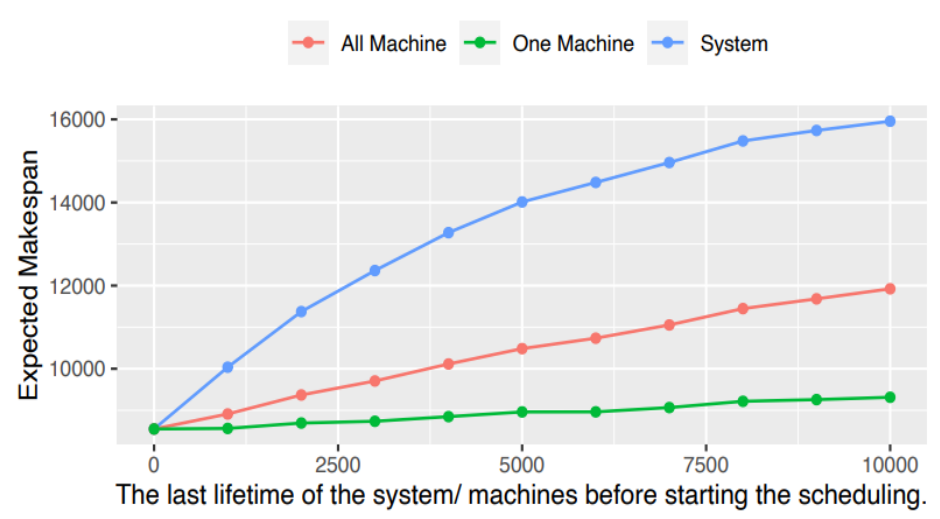
Figure 2. The Expected makespan of the system with the interval [0,10k] that indicates the last lifetime of the system/machines spent before executing the Car2 problem. In this figure 𝑷 𝒊𝒋∗ (𝒕)~ 𝑬𝑿𝑷(𝑷 line represents the Expected makespan computed according to the robust procedure in Proposition 1 and the orange one is devoted to illustrating the robust procedure in Proposition 2 applied to all machines in the system, while the green line is devoted to machine 3 in the